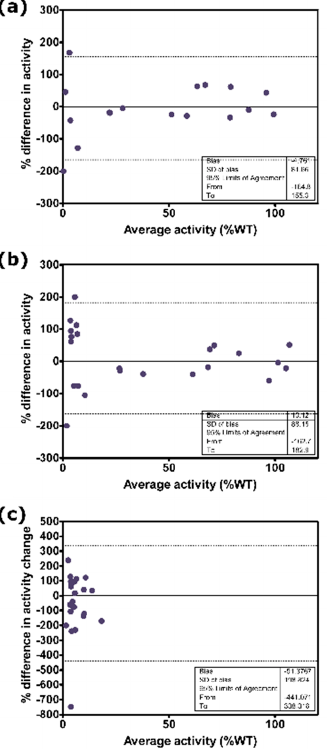
Figure A2. Bland–Altman analysis of α -Gal A activity for the 23 di ff erently classified GLA gene variants expressed as % di ff erence in activity (%WT) between the in-house assay and the GLP validated assay. ( a ) Baseline α -Gal A activity without the addition of DGJ. ( b ) α -Gal A activity with DGJ and ( c ) DGJ-induced α -Gal A activity change. The dotted line indicates the 95% limit of agreement. SD: standard